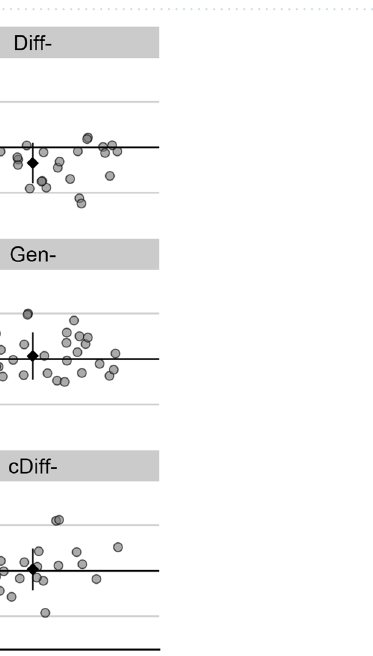
Figure 3. Group-averaged response distributions during the discrimination tasks. The proportion of ‘identical’- responses per orientation were calculated as relative frequency. The dotted vertical line represents the target orientation (CS+ for Diff and Gen, CS− for cDiff). The grand averages of the extracted means (µ) and standard deviations (SD) are noted in the diagram.